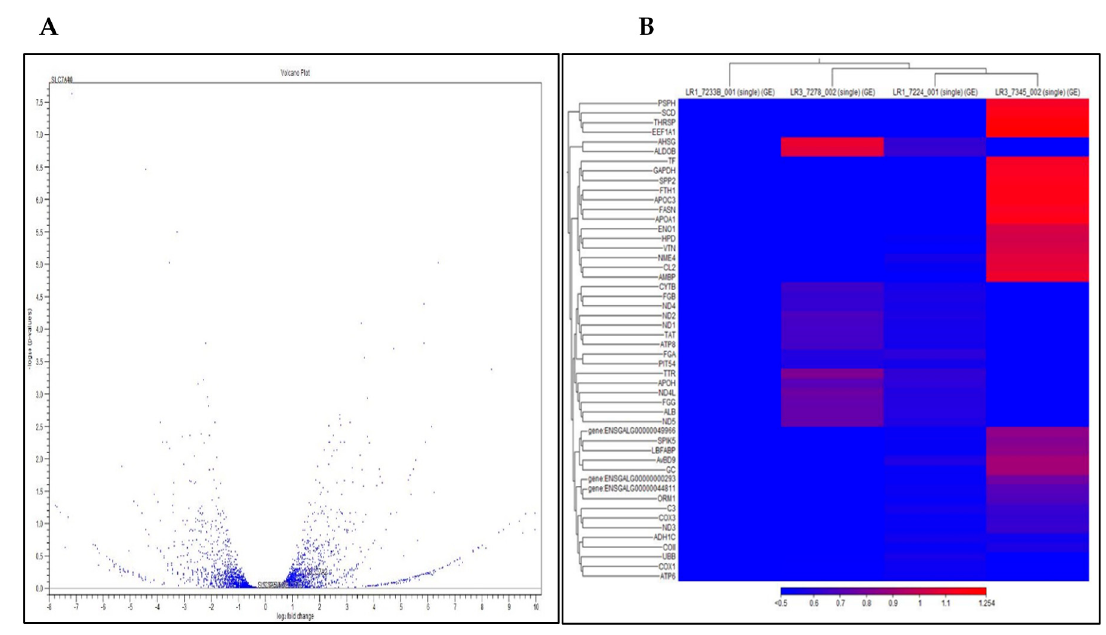
Figure 2. Expression profiles of differentially expressed genes (DEGs) in lysine-deficient and lysine-adequate treatment groups of broiler chickens. ( A ) Volcano plot of DEGs between the high and low lysine groups. ( B ) Heatmap of the expression levels of DEGs in liver tissues. The color scale below the heatmap represents log10 expression values. Red and blue colors indicate higher and lower levels, respectively.